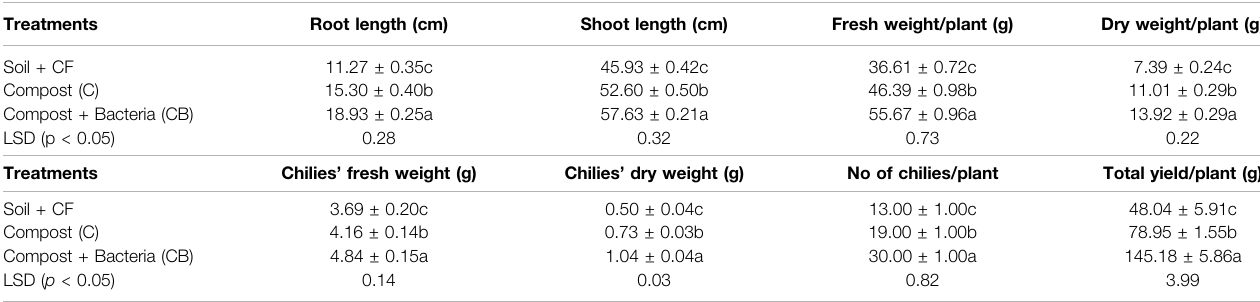
TABLE 5 | Effect of PGPR-enriched compost on the growth of chilies grown in microplots.